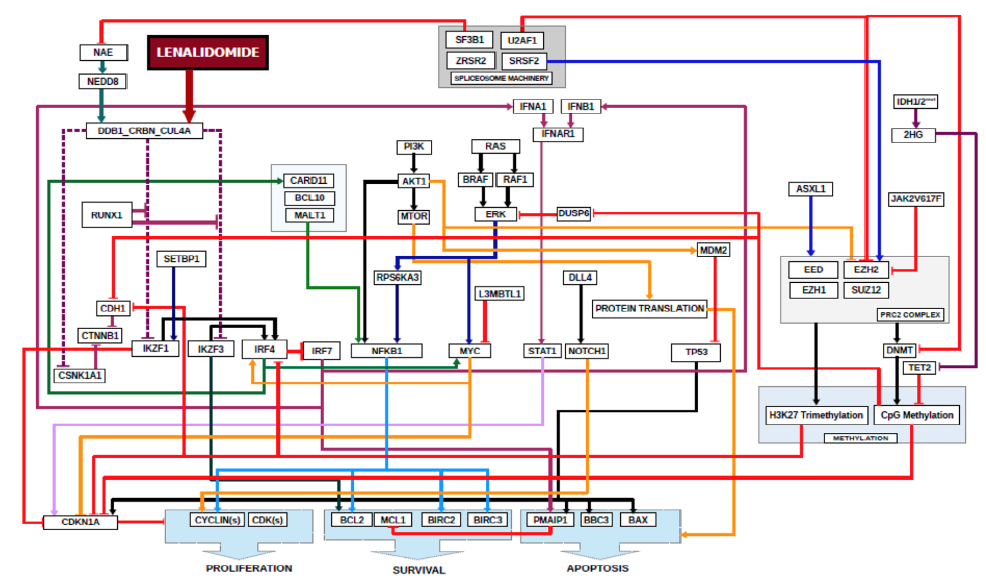
Figure 6. Schematic of Digital Lenalidomide Drug Model in MDS. Software code for lenalidomide was written to include its direct target, cereblon, and required downstream mediators that result in decreases in cell proliferation, survival and increased apoptosis. Also depicted are somatic genes frequently mutated in MDS and their relationships to downstream mediators of lenalidomide sensitivity. Arrowed lines indicate agonistic relationship. Barred lines indicate antagnostic relationship. Line colorations are to assist the human eye in discriminating among the pathways.